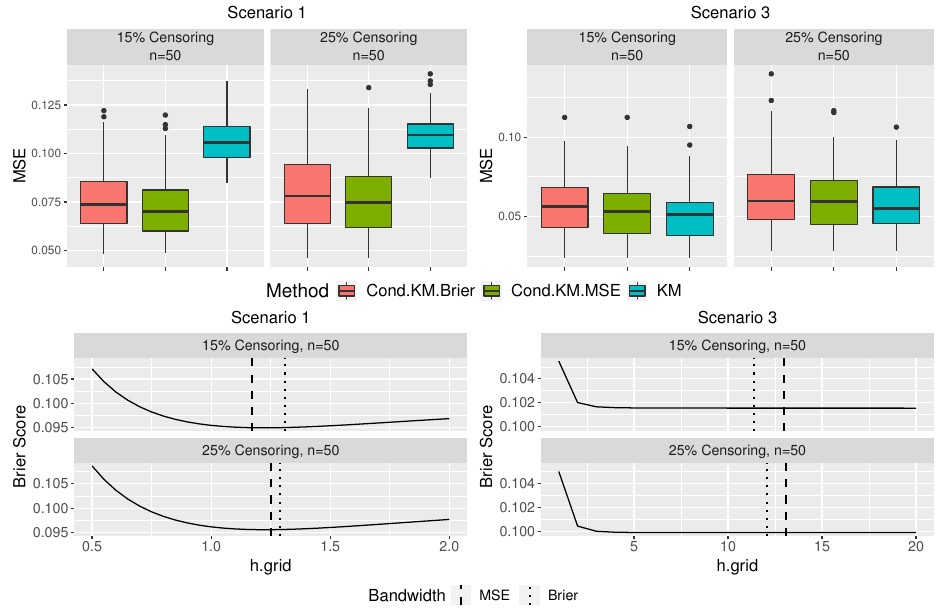
Figure A1. The boxplots of the MSPE and the average Brier score over 100 replications plotted against the grid of bandwidth for scenario 1 and scenario 3 with sample size